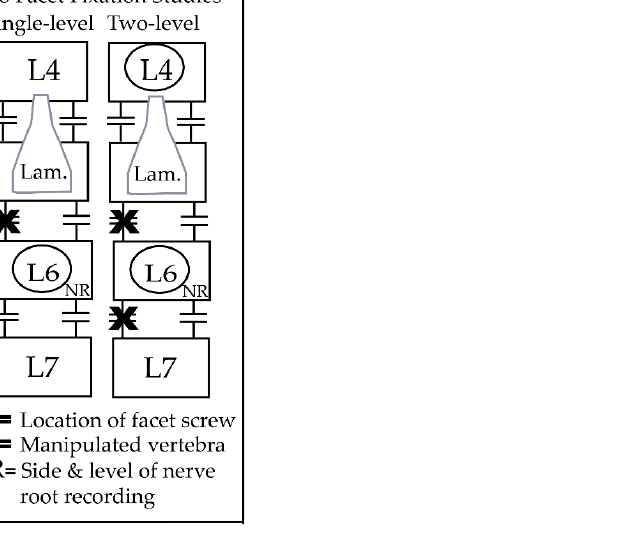
Figure 1. Diagram of single and two-level facet joint fixation experimental